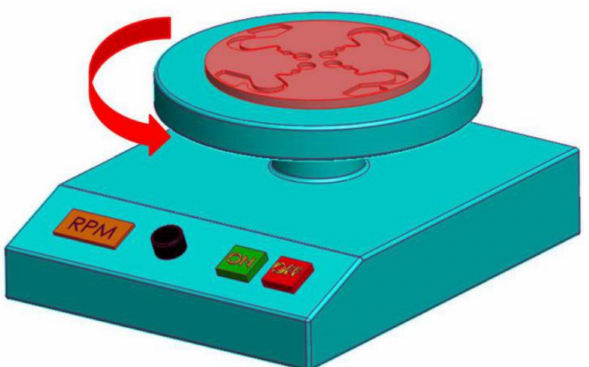
Figure 3. Schematic of the disc design on the spinning table and setting modes of the